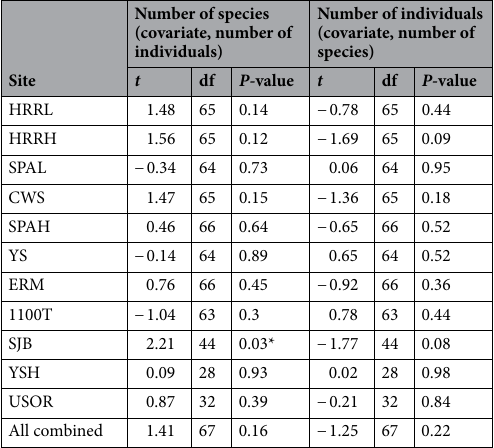
Table 3. Temporal changes in the number of species (species richness) and the number of individuals (abundances) of moths over the last 12 years in HNP. The results from a partial correlation trend analysis using the Pearson coefficient and the partial correlation coefficient are tested for significance with the student t distribution on df = n−2 degree of freedom. * P < 0.05.